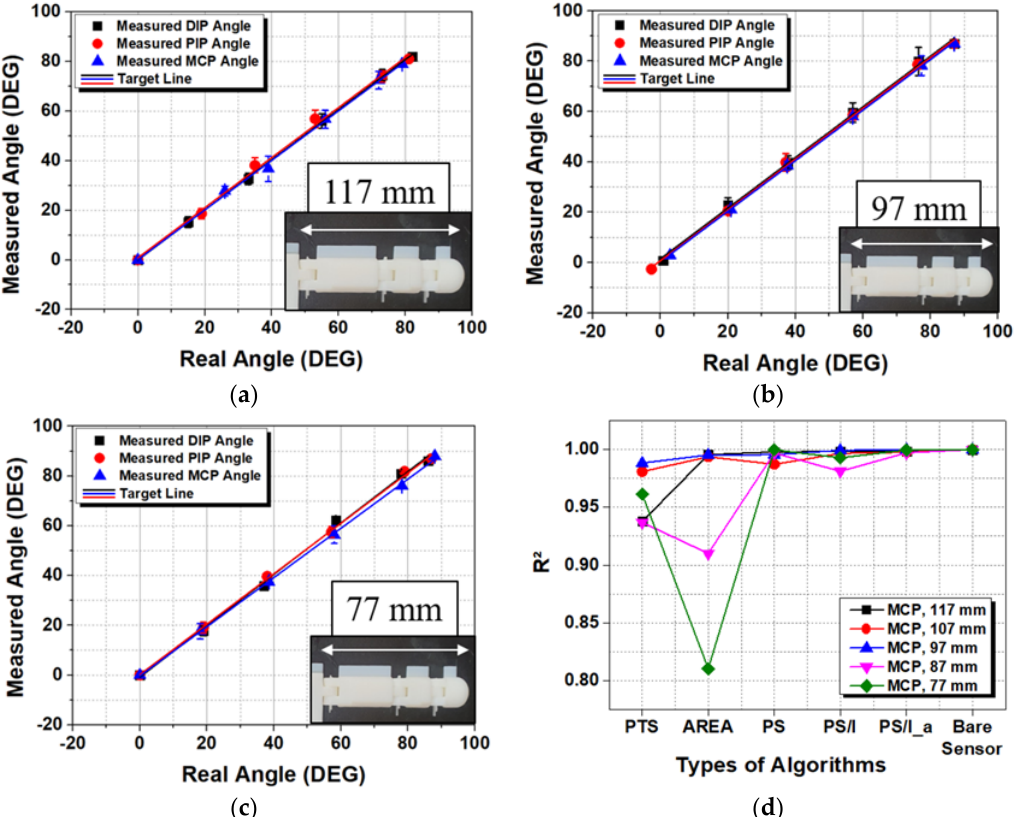
Figure 10. Measured angles versus real angles (measured by a goniometer) with respect to the length of the index finger: ( a ) 117, ( b ) 97, and ( c ) 77 mm. ( d ) Linearity of the measured MCP joint angle according to the algorithm and finger length.